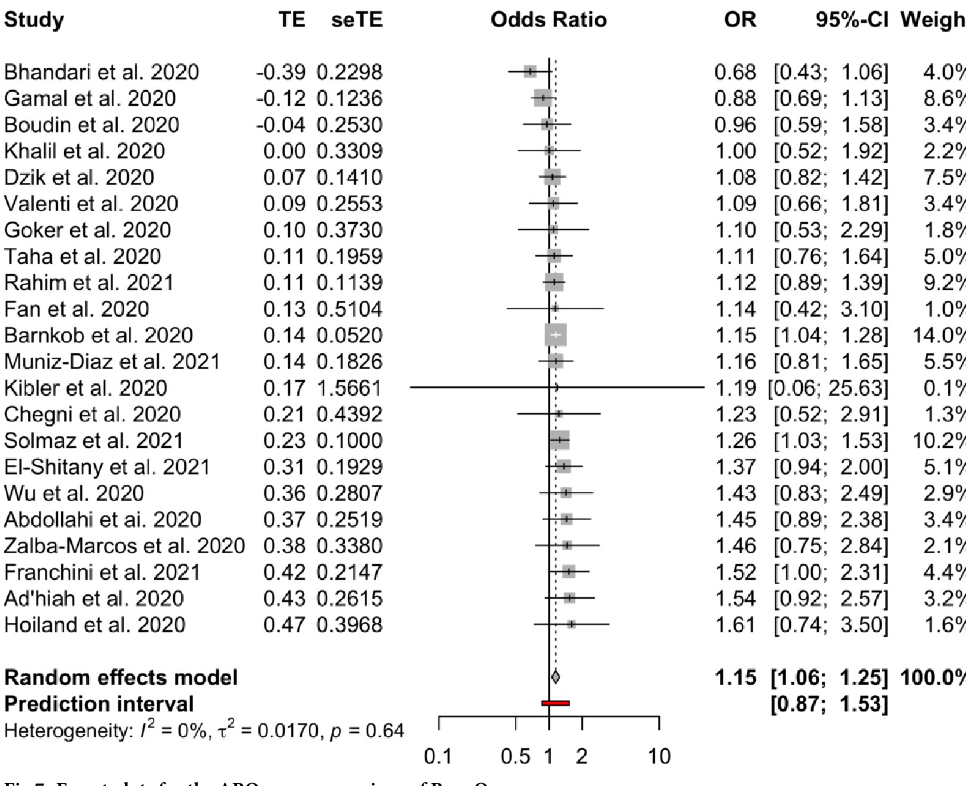
PLOS ONE | https://doi.org/10.1371/journal.pone.0271451 July 28,